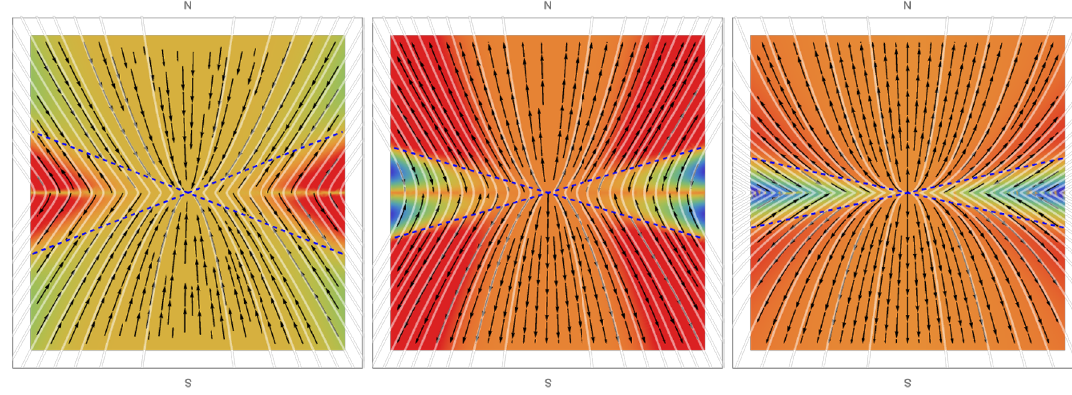
Figure 5 . Polar vector plots of the (ZAMO) Poynting flux stream lines for the NHEK, AdS-NHEK and SE-NHEK solution, in the ( r, θ ) plane of the near horizon geometry. The flux changes sign at the critical angle θ c (blue dashed lines). The density plot shows the magnitude of the radial Poynting flux ranging from negative (purple) over zero (yellow) to positive (red). Along the flux lines, the angular velocity ω F is constant (white solid lines) in agreement with the conducting cylinder toy model.